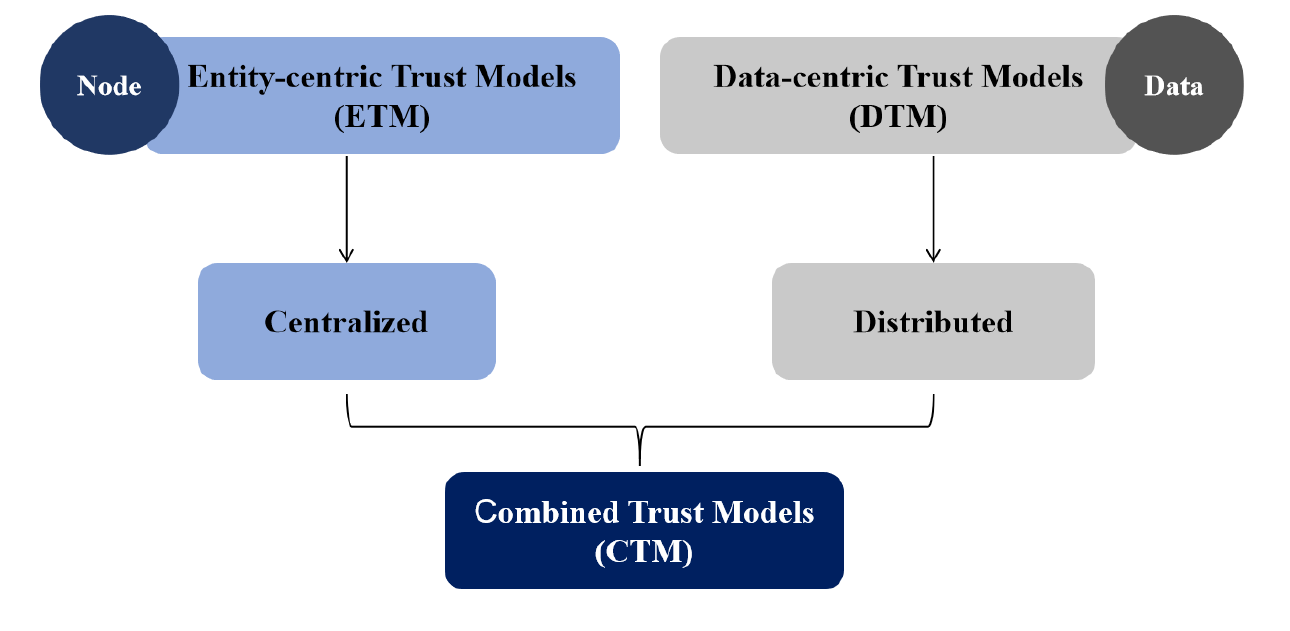
Figure 6. Classification of trust